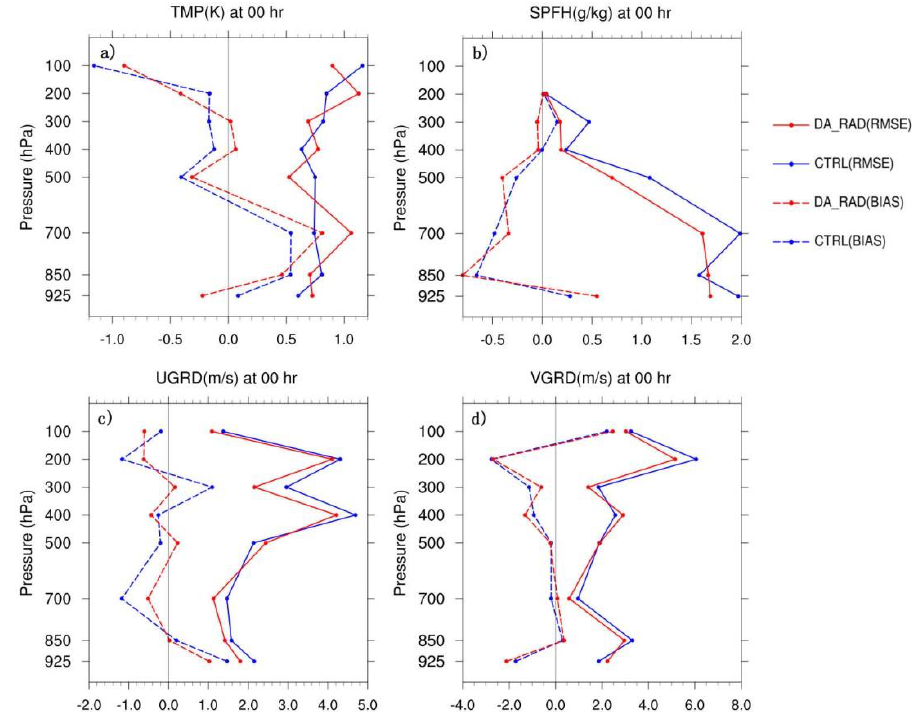
Figure 7. The error statistics in vertical levels for temperature, humidity, and wind at the time 0 h of forecasts against sounding observations, including the average bias and RMSE for ( a ) temperature (TMP), ( b ) specific humidity (SPFH), ( c ) zonal wind (UGRD), and ( d ) meridional wind (VGRD).